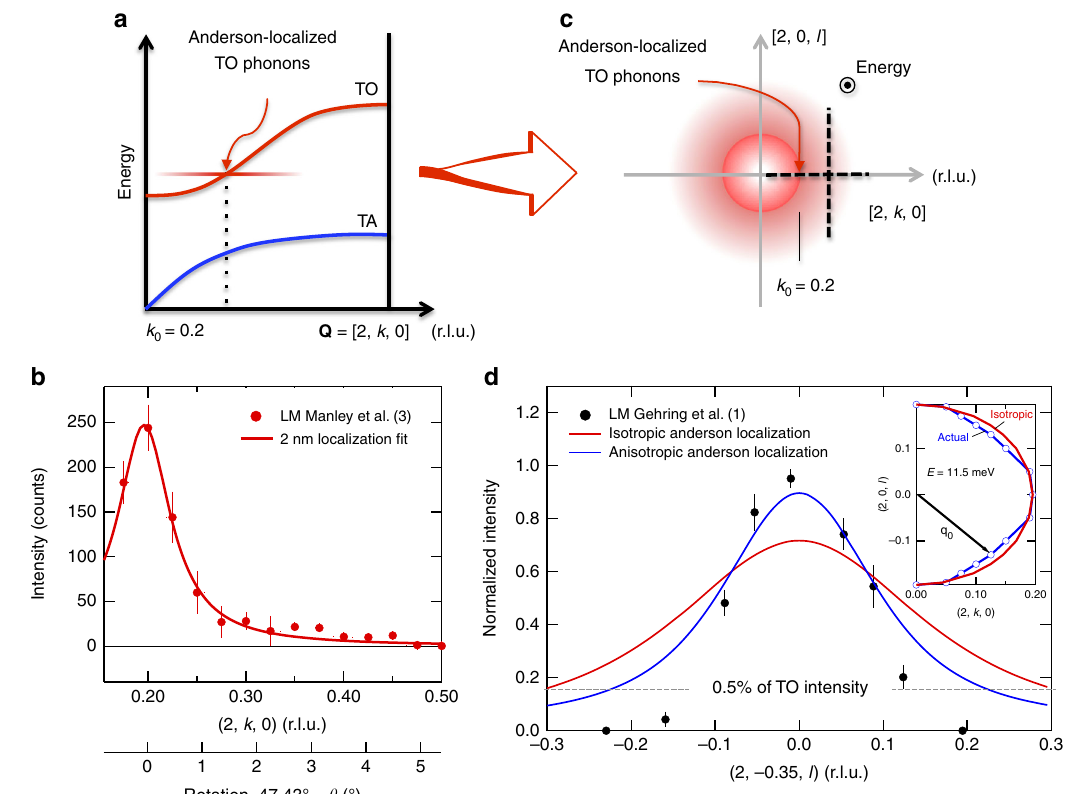
Fig. 1 Analysis of the phonon localization structure in PMN-30%PT. a The structure of the Anderson-localized TO phonon in the high-symmetry direction appears dispersionless with an intensity maximum at the TO phonon, taken from our previous work 3 . b Measured local mode (LM) intensity pro fi le along Q = [2, k , 0] with a 2 nm phonon localization fi t, after our original work 3 . The extra axis at the bottom shows the crystal rotation angle θ for a more direct comparison with the tilt angle used by Gehring et al. 1 . c Projection of phonon localization pro fi le in (2 kl ) plane assuming an isotropic TO phonon. In this view, energy points out of the page as indicated by the dot in circle. d Calculated phonon localization intensity pro fi le compared with the tilting results of Gehring et al. 1 ( l ¼ 2 : 03 ´ sin ð tiltangle Þ ). The inset shows the measured anisotropy in the TO phonon, which was obtained from our original data 3 . The lowest data points corresponding to LM intensities less than ~0.5% of the TO phonon are likely below the detection limit of the instrument. In our measurements on BT7 the TO phonon peak counts 3 of around 200 were about equal to the background intensity, so N ph ~ N bkg = N . The statistical noise in ffiffiffiffi p N the background is and a small peak with a fraction, f , of the phonon will have counts fN ph ~ fN . At the detection limit, this gives N ~ 1/ f 2 . For f = 0.1%, N > 1,000,000 counts are needed, which requires counting more than 1000 times longer than we